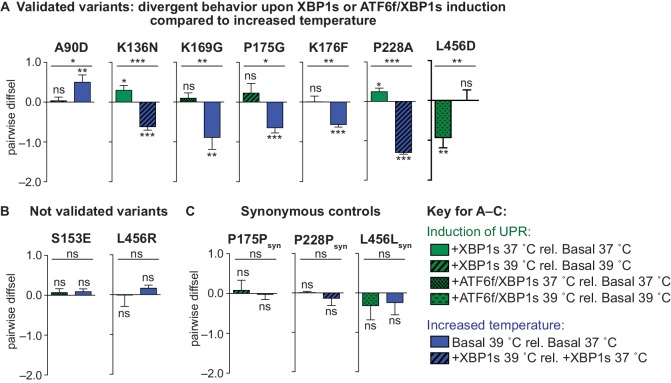
Individual pairwise competition diffsel values.(A) Diffsel of validated variants in pairwise competition with wild-type influenza upon induction of XBP1s or ATF6f/XBP1s and increased temperature. Variants were considered ‘validated’ if the diffsel upon induction of XBP1s or ATF6f/XBP1s was significantly different from that upon increased temperature. (B) Diffsel of non-validated variants in pairwise competition. (C) Diffsel of synonymous mutants in pairwise competition. For (A–C), the average of biological triplicates is plotted with error bars corresponding to SEM. Asterisks comparing selection conditions represent significance evaluated by Student’s t-test, while asterisks comparing an individual selection condition to no selection (diffsel of zero) represent significance evaluated by a one-sample t-test. For all significance tests, *, **, and *** represent two-tailed p-values≤0.05, 0.01, and 0.001, respectively; ‘ns’ corresponds to a p-value>0.05. Induction of UPR conditions in green corresponds to ΔUPR in Figure 6; increased temperature conditions in blue correspond to ΔT in Figure 6.